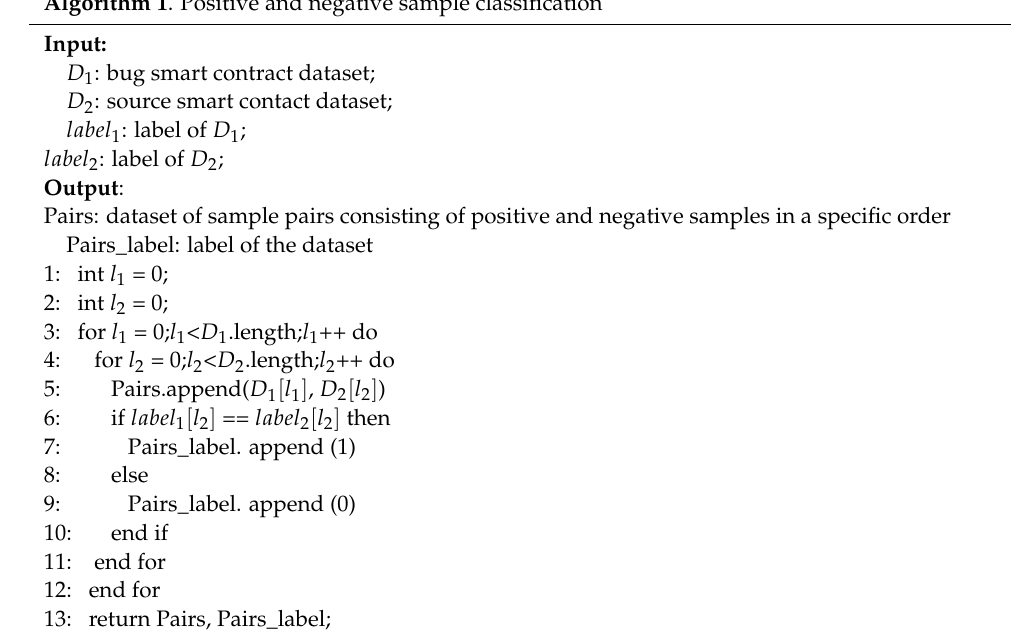
Algorithm 1 . Positive and negative sample